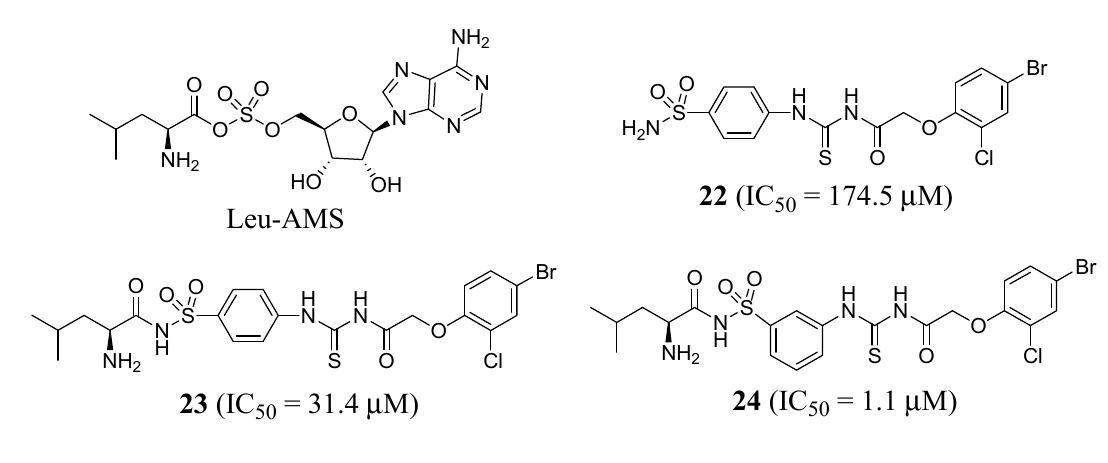
Figure 9. Structures of LeuRS